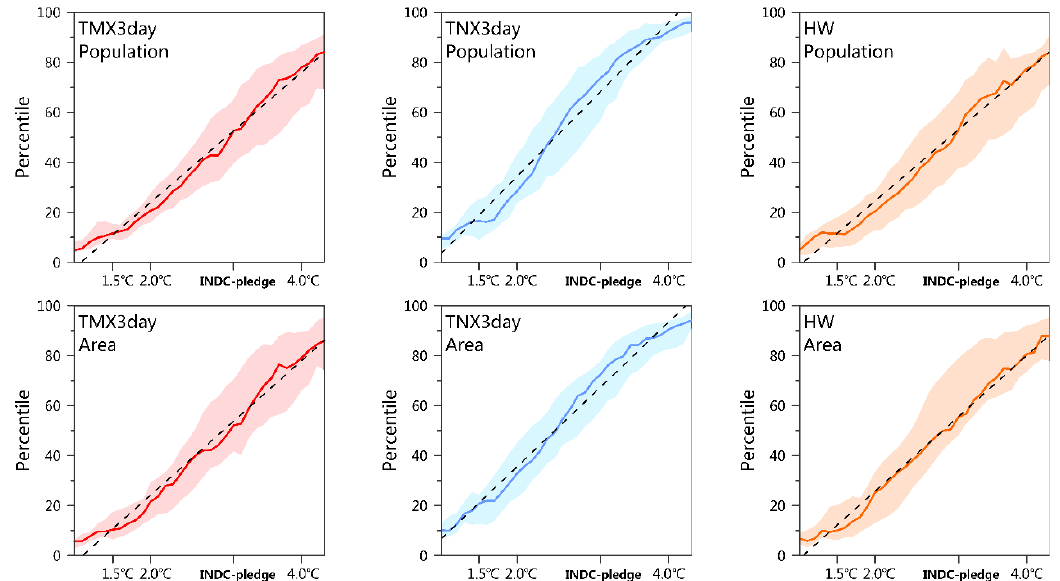
Figure 6. The fraction of the population and area in Central Asia for which the historical TMX3day (column I), TNX3day (column II), and HW (column III) record defined from 1961–2005 is broken under different global warming levels. The multi-model medians are the solid lines and the interquartile ranges are shaded. The dashed black lines denote the linear trend of the population/area fraction with the global mean warming. Fractions of the population and area in five subregions refer to Figure S4.